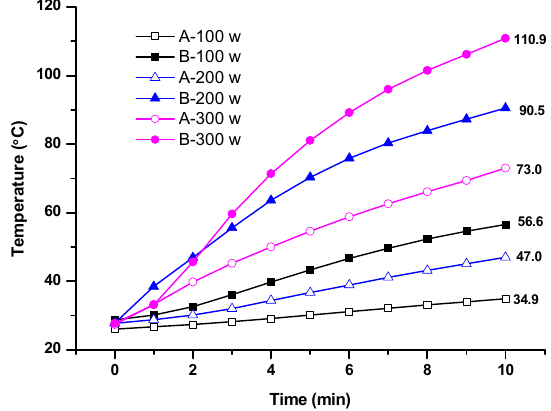
Table 1. The heating rate of 20 g of oleic acid (A) and 20 g of oleic acid with 1 g of catalyst (B) at various microwave powers.